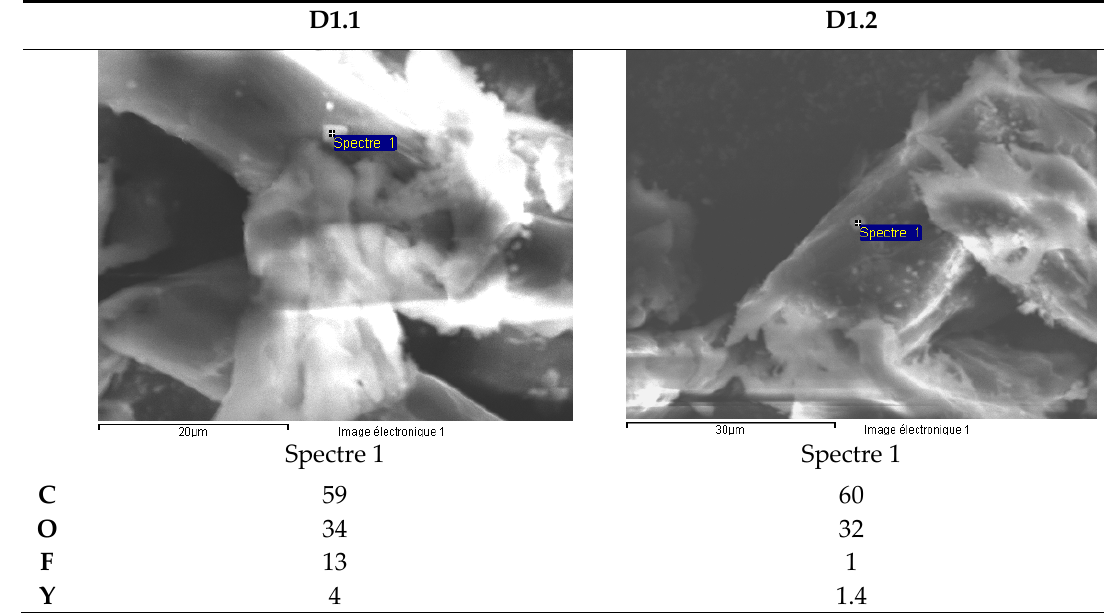
Figure 12. White ceramic watch link (D1.1 and D1.2). Scanning electron microscope (SEM) analysis of microfibers from filter paper.